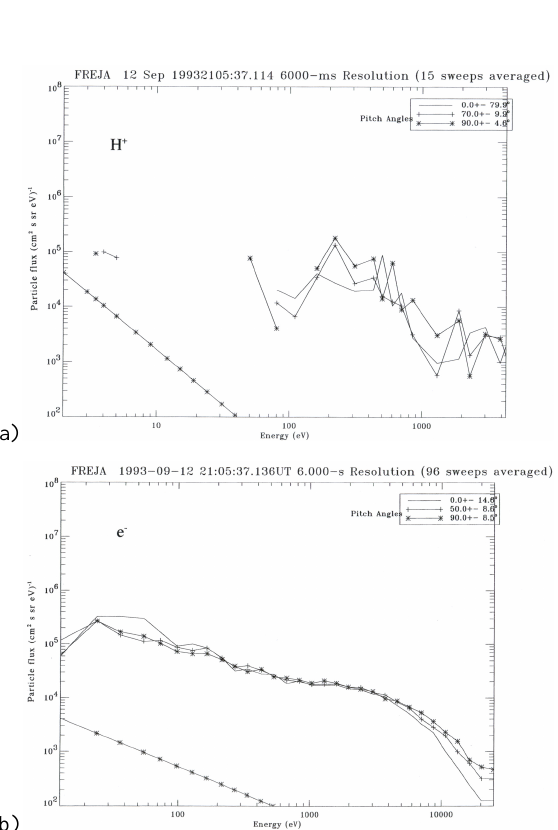
Fig.21. A 2-min CSP showing a strong increase in electron energy at about 21:05:35UT which is accompanied by a decrease in the energy of precipitated H + ions and an increase in the ion flux.